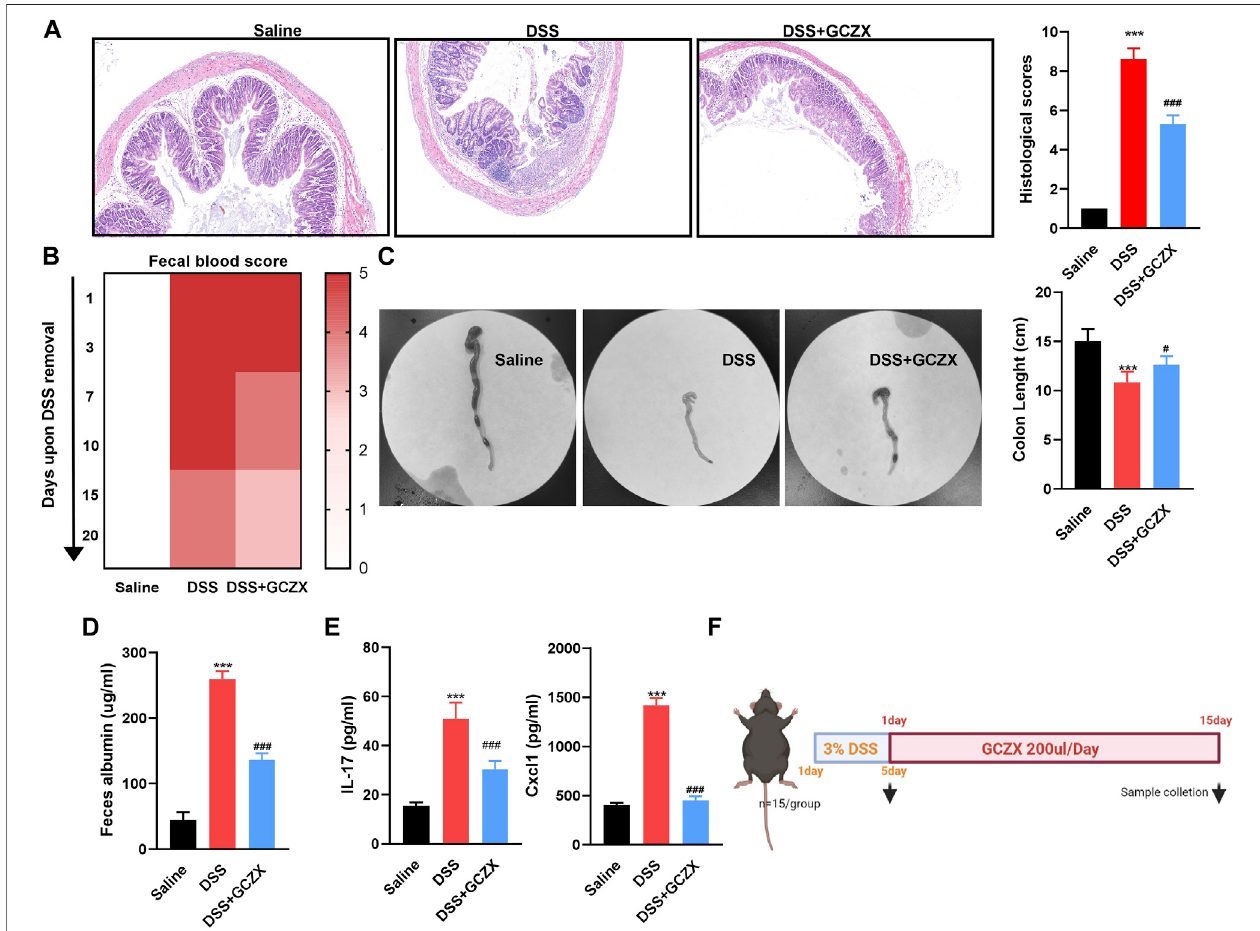
FIGURE 1 | GCZX alleviates UC progression HE staining images of colon sections (A) , fecal occult blood test (B) , colon tissue (C) , albumin level (D) , IL-17 and CXCL1 levels (E) from C57 mice subject to 4% DSS administration with GCZX; Flow chart of experimental design (F) . * p < 0.05, ** p < 0.01, and *** p < 0.001 indicates a statistically signi fi cant difference from saline group; # indicate statistically signi fi cant difference from UC group.